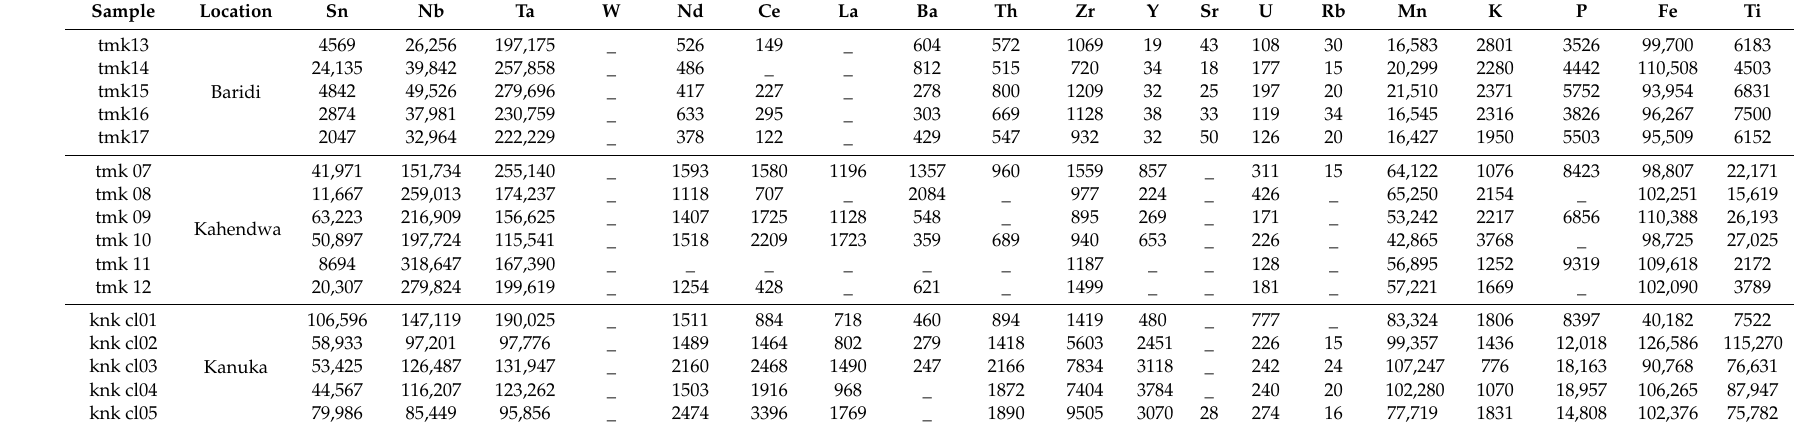
Table 6. Chemical analysis of coltan ore samples (in ppm). _Not